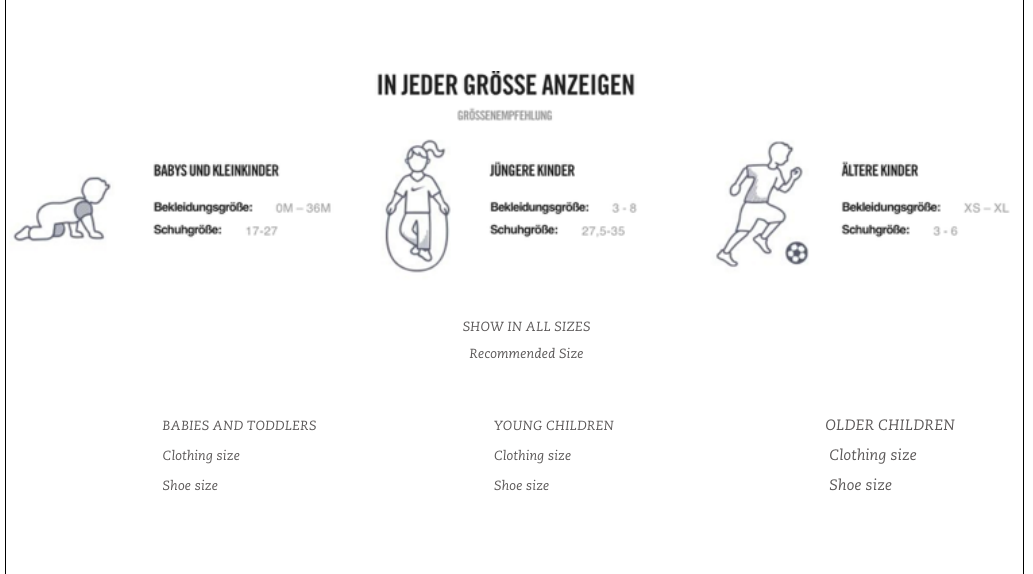
Figure 1 (bottom): Gender stereotypes can be found in several details of the Nike website. The sizing of children's fashion takes place in three steps: the category “Babies and Toddlers” is depicted rather gender neutral, while the category “Younger Children” is obviously attributed to girls (illus. skipping rope), and the third one of the older children to the boys (illus. playing football). Source: http://nike.com/ de/de_de. Accessed: November 19,